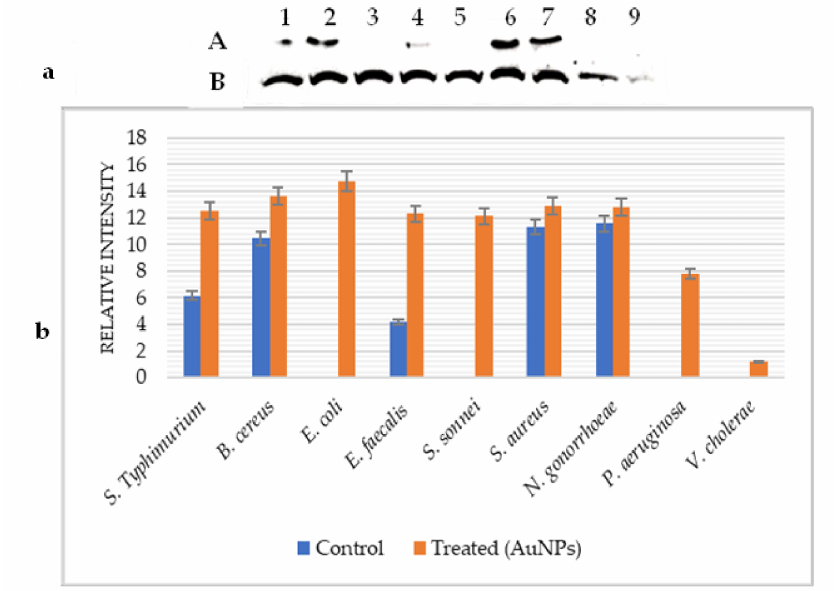
Figure 3. GroEl heat shock protein expression under AuNPs effect. ( a ): Western blot analysis; ( b ): Image-J bands quantification; (A): Control; (B): Treated (AuNPs) S. Typhimurium (1), B. cereus (2), E. coli (3), E. faecalis (4), S. sonnei (5), S. aureus (6), N. gonorrhoeae (7), P. aeruginosa (8), and V. cholerae (9). After treatment with AuNPs, GroEL was induced in all tested bacteria. Its level of expression was considerably increased in E. faecalis (66.04%), S. Typhimurium (50.83%), and B. cereus (23.35%). This Hsp was slightly induced in S. aureus (12.5%) and N. gonorrhoeae (9.64%). The very high and low expression levels of GroEL were detected in E. coli and V. cholerae , respectively (Figure